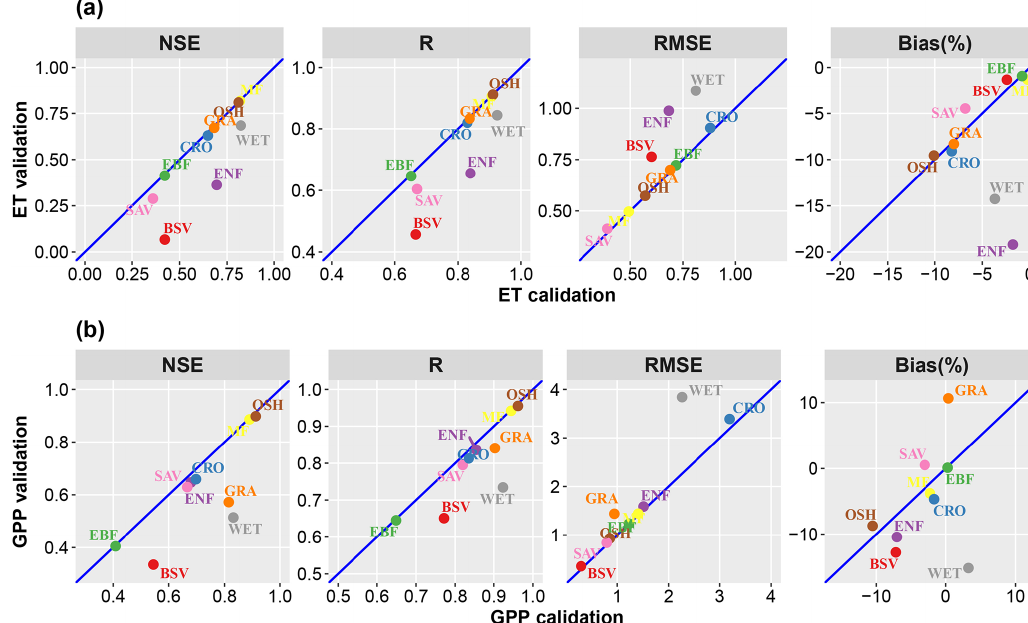
Figure 4. Comparison of ET and GPP between PML-V2(China) model calibration and validation across 10